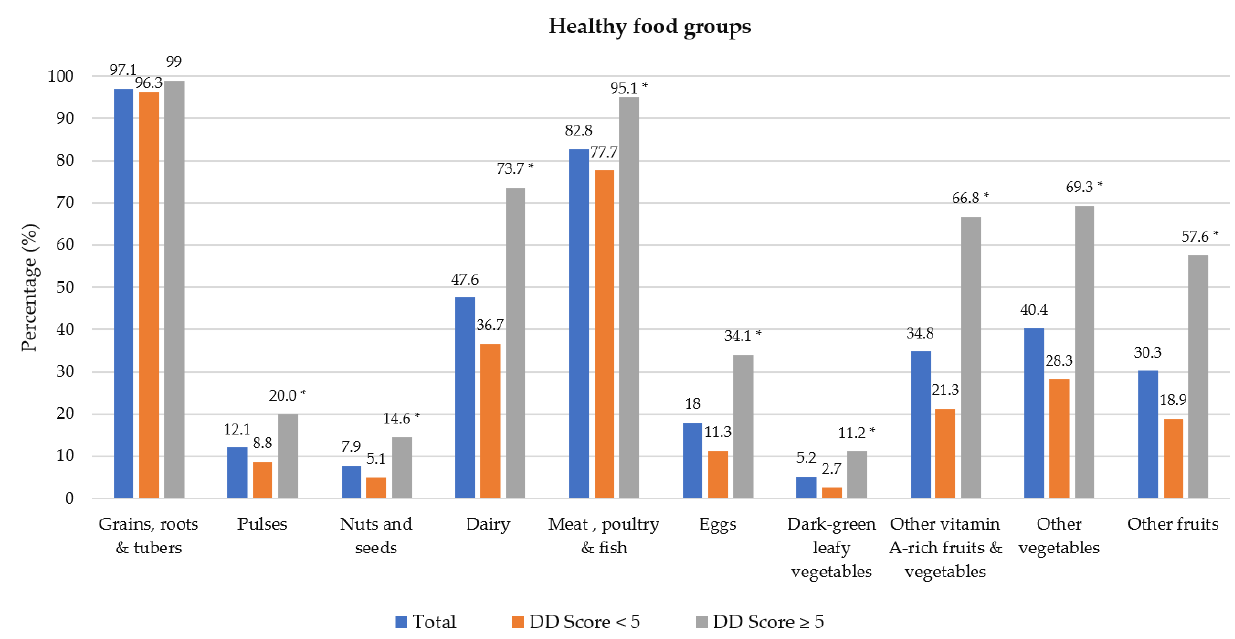
Figure 1. Percentage of participants who consumed healthy food groups the previous day by dietary diversity (DD) score categories. * Significant difference between DD score categories at p < 0.001 level, Chi-square test.